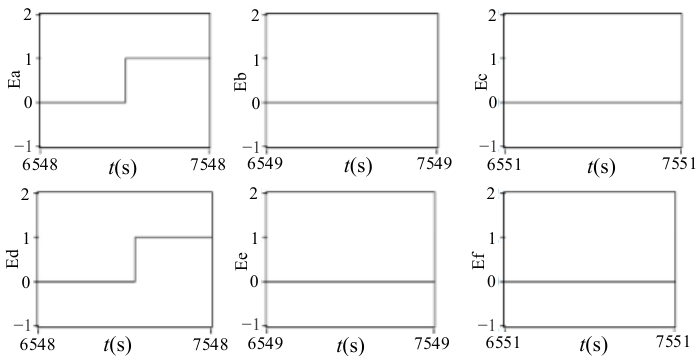
Figure 31. Fault index waveform in case of phase failure of phase a .